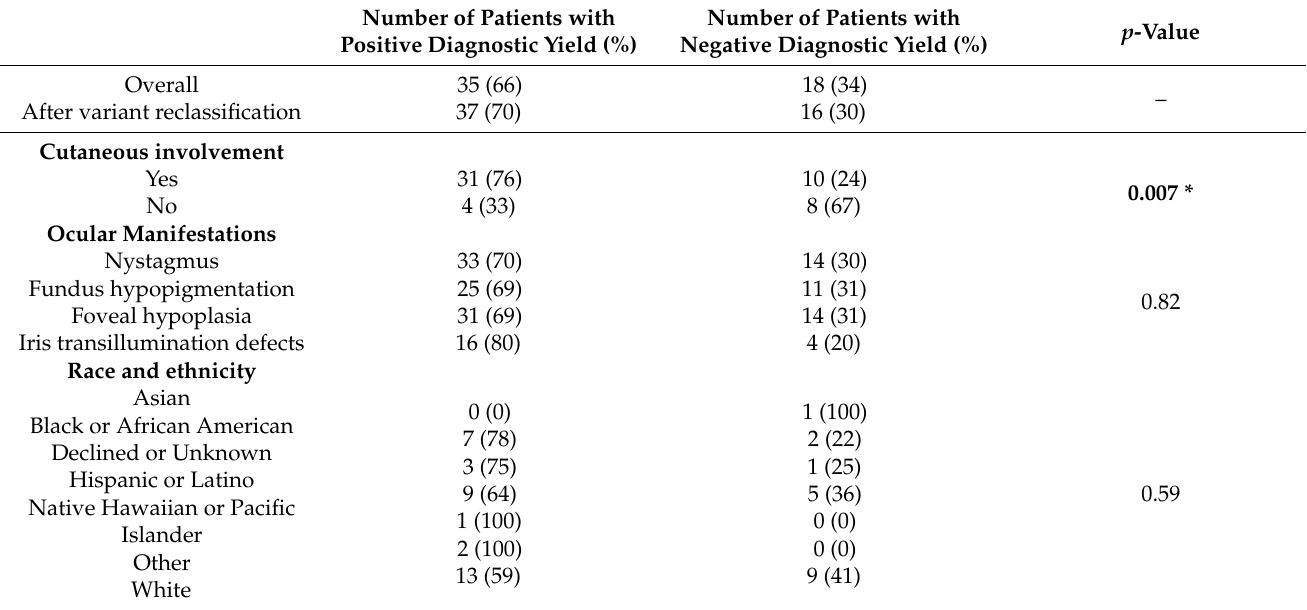
Table 2. Number of patients with positive and negative diagnostic yield based on presence of pa- tient factors. Comparison within variables performed via Chi-square analysis.